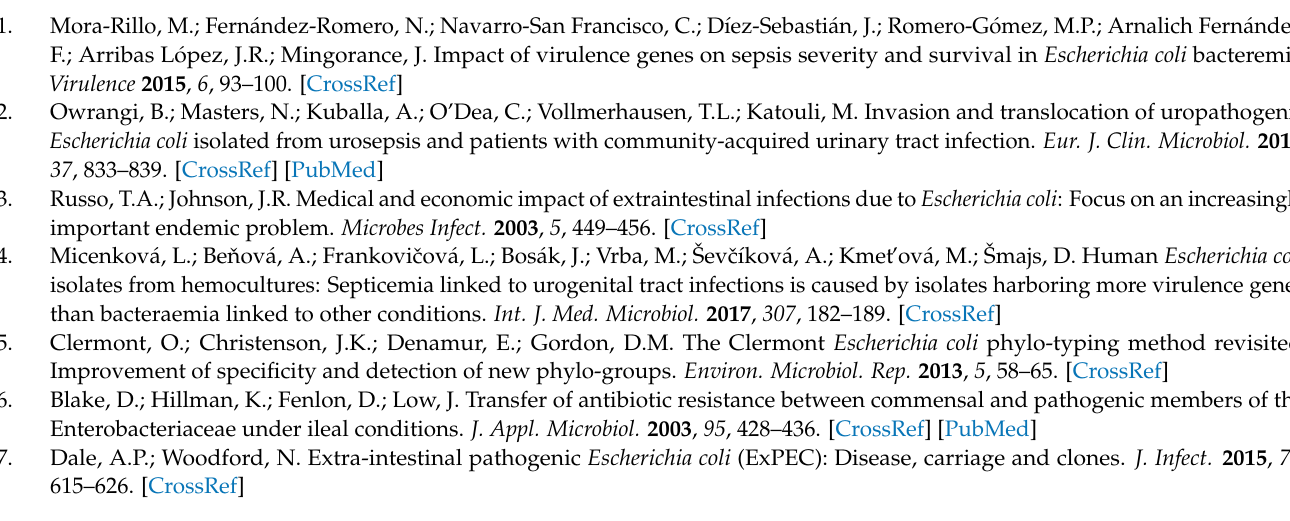
logenetic group A. Figure S2: Dendrogram of phylogenetic group B2. Figure S3: Dendrogram of phylogenetic group F. Figure S4: BOX-PCR